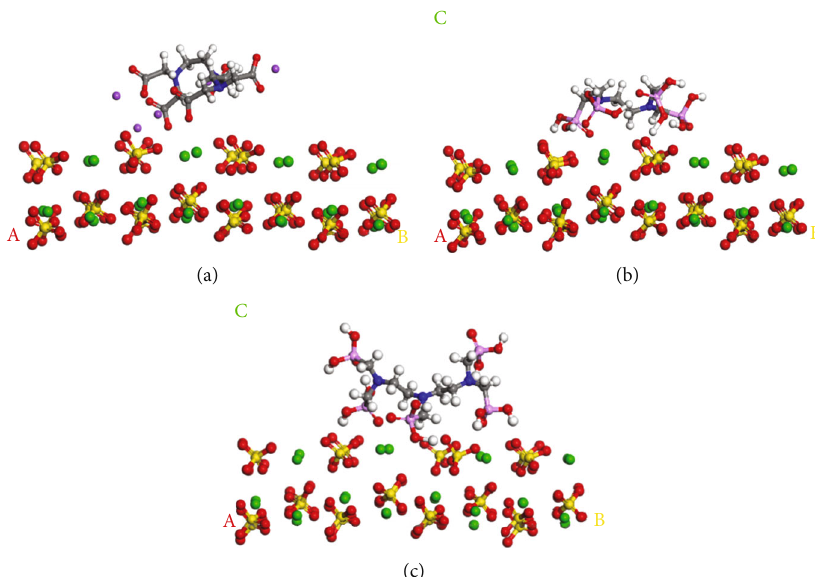
Figure 5: (210) Surface of barium sulfate is interacting with (a